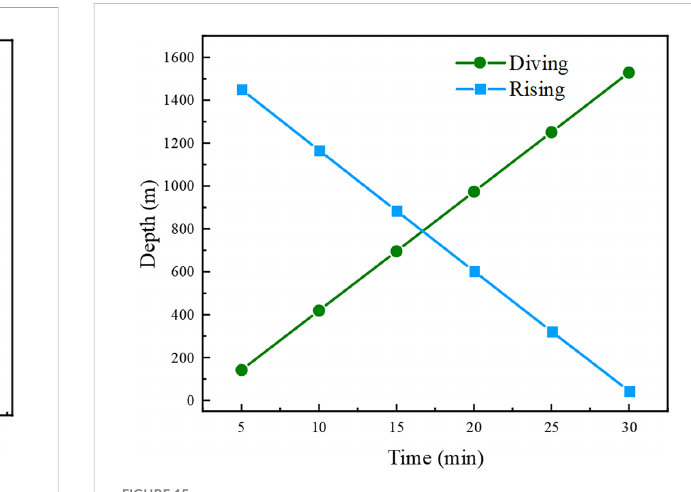
FIGURE 15 The depth change of the lander during the diving and